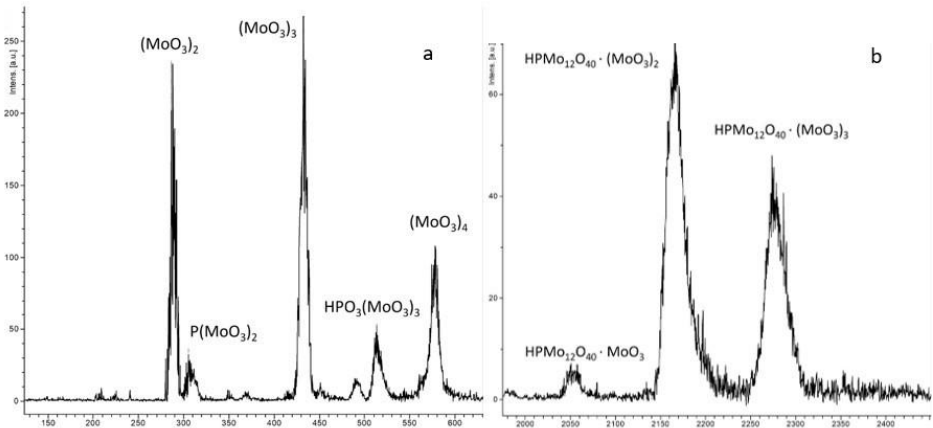
Figure A5. SALDI mass spectra of the PMo1 catalyst—in the region of low ( a ) and high ( b ) masses in